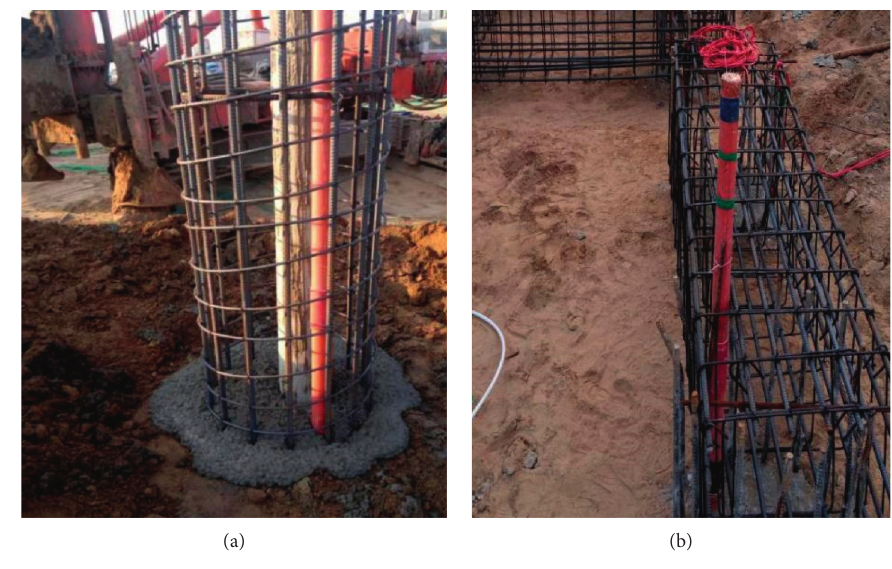
Figure 9: Inclinometer pipe site